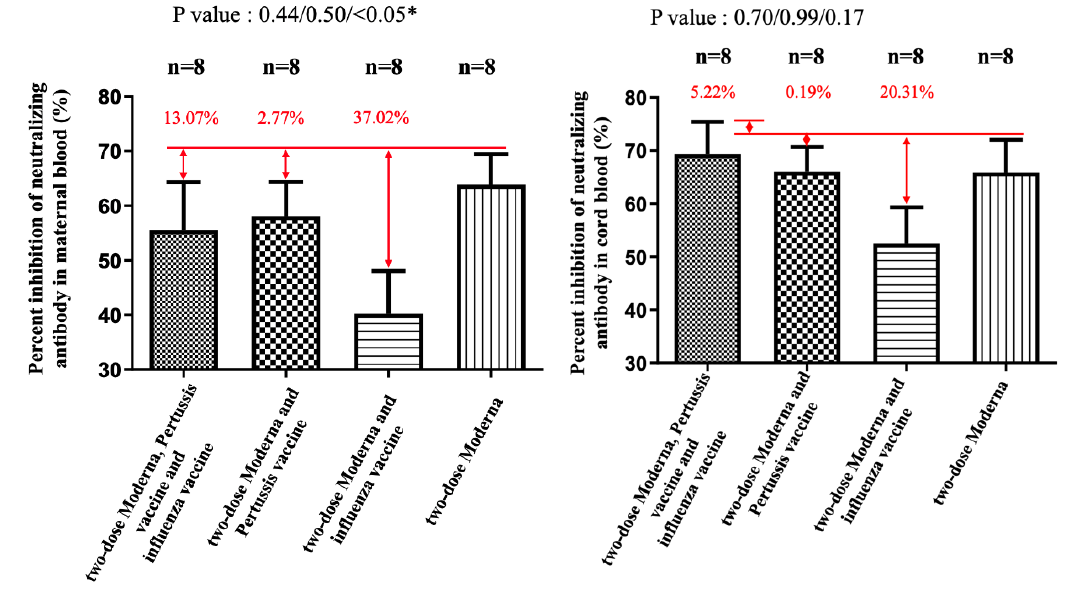
Figure 4. The percentage of inhibition of neutralizing antibody (%) against the Delta variant in maternal and cord blood. In the Moderna + Tdap + influenza group, there was a 13.07% reduction ( p = 0.44) in maternal blood and a 5.22% ( p = 0.70) increase in cord blood compared with the Moderna only. In the Moderna + Tdap group, there was a 2.77% decrease ( p = 0.50) in maternal blood and a 0.19% ( p = 0.99) reduction in cord blood compared with the Moderna only. In the Moderna + influenza group, there was a 37.02% decrease ( p < 0.05) in maternal blood and a 20.31% ( p = 0.17) reduction in cord blood compared with the Moderna only. *indicates statistically significant.